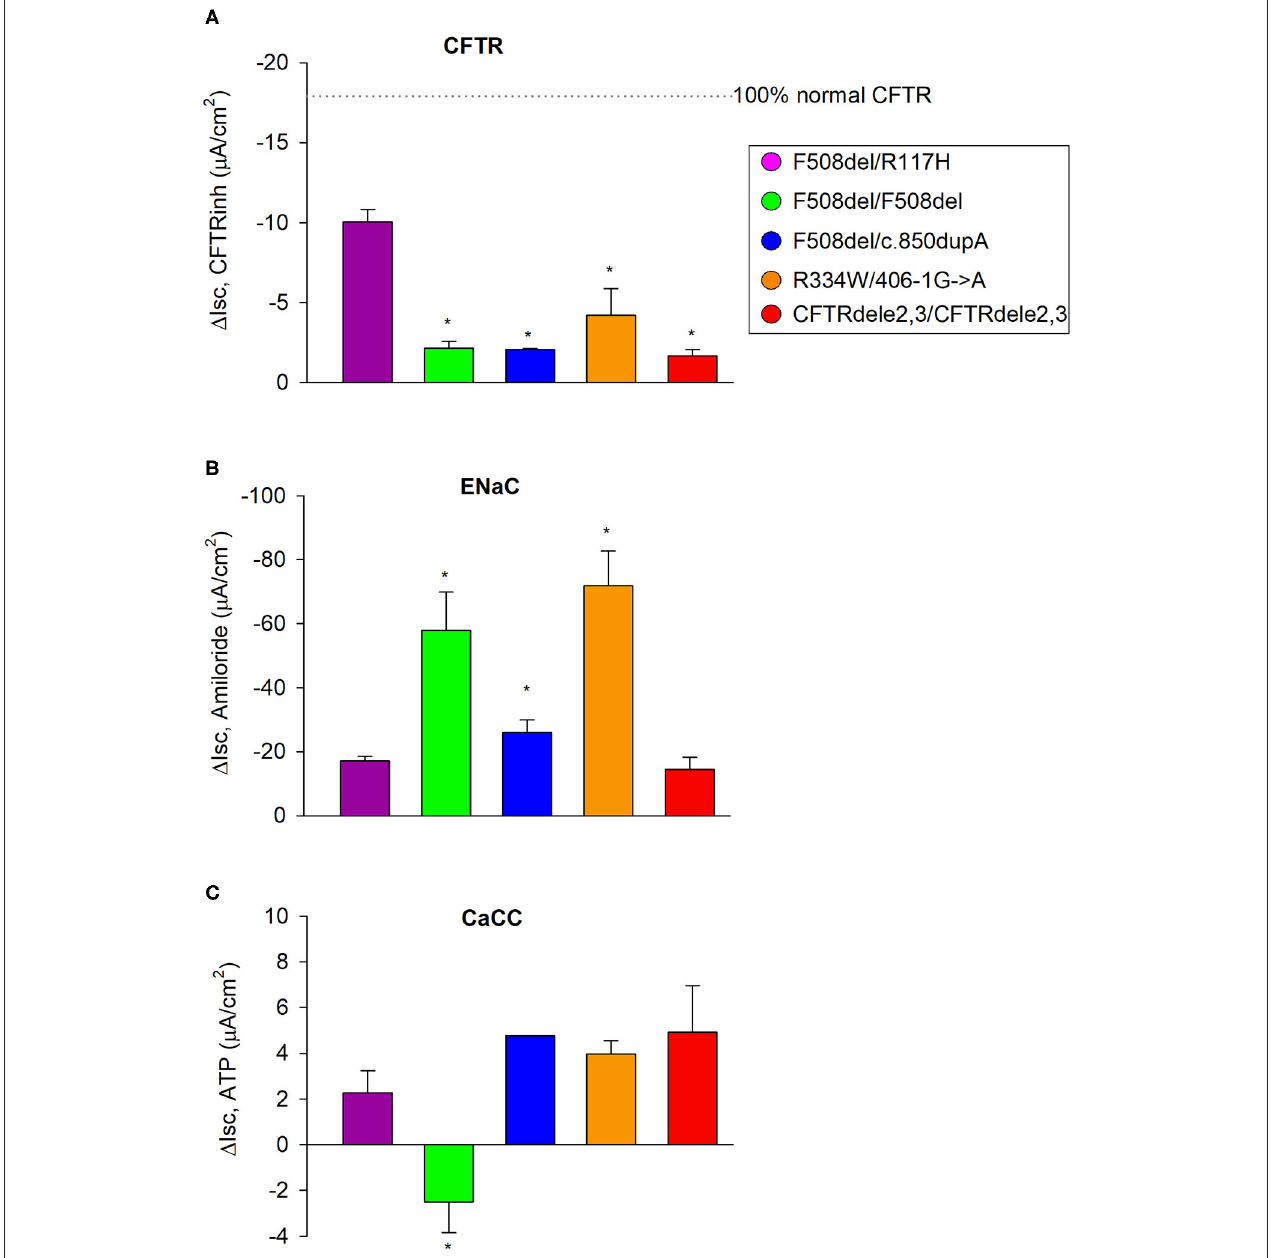
FIGURE 7 | CFTR, ENaC, and CaCC activities of EpiX TM expanded CF patient cultures. (A) The F508del/R117H-7H genotype was used as an internal reference to compare CFTR function among genotypes. CFTR function was quantified from the forskolin plus VX-770 stimulated current that was blockable by CFTR inhibitors and in cultures that received no CFTR corrector treatment. (B) Corresponding ENaC activity was quantified by measuring the change in current before and after addition of amiloride. Note that ENaC activity was significantly increased in cultures with the F508del/F508del or R334W/406-1G- > A genotype. (C) Corresponding CaCC activity was quantified by measuring the change in current before addition of ATP and the maximal current stimulated by ATP (peak). Note that ATP induced a decrease in Isc in cultures with the F508del/F508del genotype suggesting that other conductances dominated the secretory response to ATP. All other cultures showed a chloride secretory response to ATP. Bars represent mean ± SE ( n = 2–13 experiments per genotype). *denotes significantly different from F508del/R117H control group (Holm-Sidak, p < 0.05).